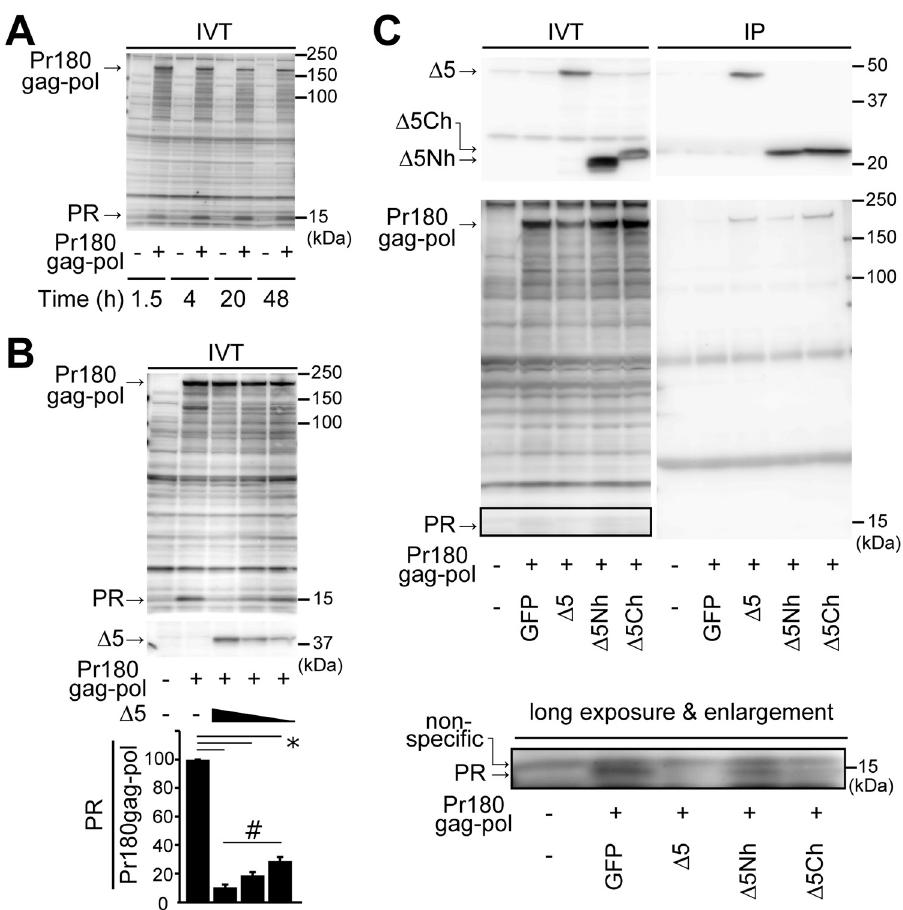
Fig 7. mA3 binds to Pr180gag-pol mainly through its C-terminal half and reduces mature viral protease. (A) Assays for Pr180gag-pol autoprocessing using the in vitro transcription and translation (IVT) system. No template DNA ( − ) or 1 μ g of pT7CFE1-Pr180gag-pol(57) (+) was added to the IVT reaction. The reaction mixture was incubated for the indicated duration at 30˚C, reaction stopped by the addition of Laemmli SDS sample buffer, and the expressed proteins analyzed by immunoblotting using the rabbit anti-MuLV protease Ab. (B) The effect of Δ 5 mA3 on Pr180gag-pol autoprocessing analyzed by using the IVT system. Into the IVT reaction 0.38 μ g of pT7CFE1-Pr180gag- pol(57) was added along with 0.26, 0.17 or 0.09 μ g of pT7CFE1- Δ 5mA3. The mixture was incubated for 20 hours at 30˚C. The lysates were analyzed by immunoblotting. To detect Δ 5 mA3, the anti-FLAG mAb was used as it is expressed as tagged protein. The rabbit anti-MuLV protease Ab was used to detect PR and Pr180gag-pol. The band intensities of PR and Pr180gag-pol on the same blot were measured and PR/Pr180gag-pol ratios were calculated (the bar chart). The data represent means with standard errors from three independent experiments. � , P < 0.001 for the three indicated comparisons; #, P < 0.01 by one-way ANOVA with Tukey’s multiple comparison tests. (C) Into the IVT reaction, 0.38 μ g of pT7CFE1-Pr180gag-pol(57) was added (+) along with 0.2 μ g of pCFE-GFP control (GFP), pT7CFE1- Δ 5 mA3 ( Δ 5), pT7CFE1- Δ 5 mA3 N-half ( Δ 5Nh) or pT7CFE1- Δ 5 mA3 C-half ( Δ 5Ch) expression plasmid. The mixture was incubated for 20 hours at 30˚C. A portion of the reaction mixture was analyzed by immunoblotting (IVT). The image taken after a long exposure time is also shown in the bottom. Another portion of the mixture was used for the immunoprecipitation assay using the anti-FLAG Ab to precipitate FLAG-tagged mA3, and the precipitates were analyzed by immunoblotting to detect bound protease or its precursor (IP). The rabbit anti-MuLV protease Ab was used to detect PR and Pr180gag-pol. Anti-FLAG mAb M2 were used to detect flag-tagged mA3